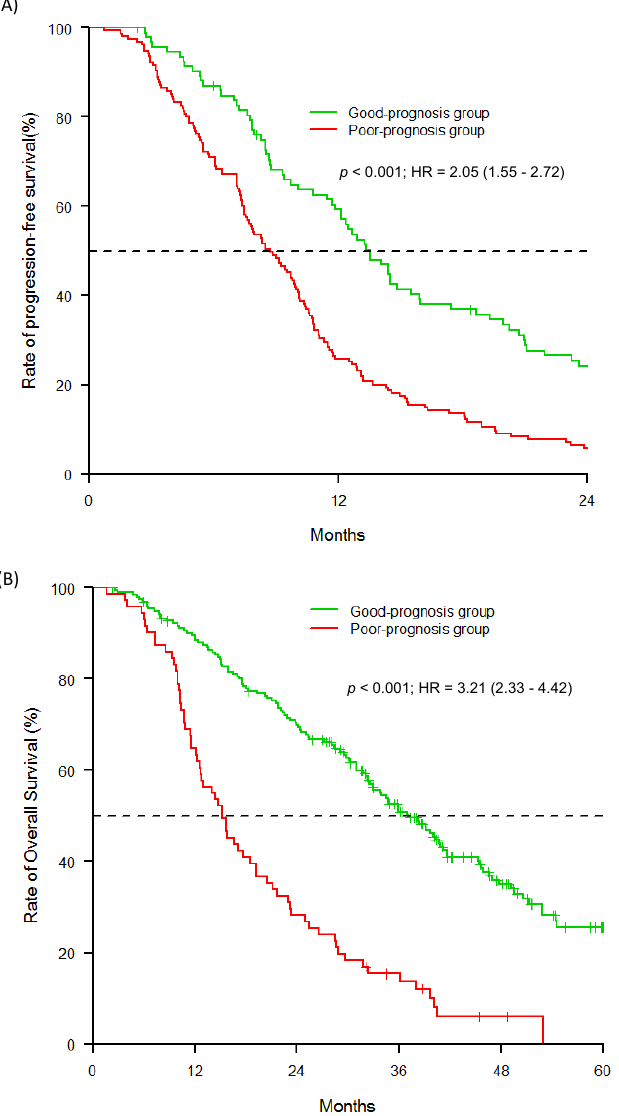
Figure 2. Receiver operating characteristic (ROC) curves and AUC for risk scores for three models. ( A ) PFS at 24 months; ( B ) OS at 60 months.